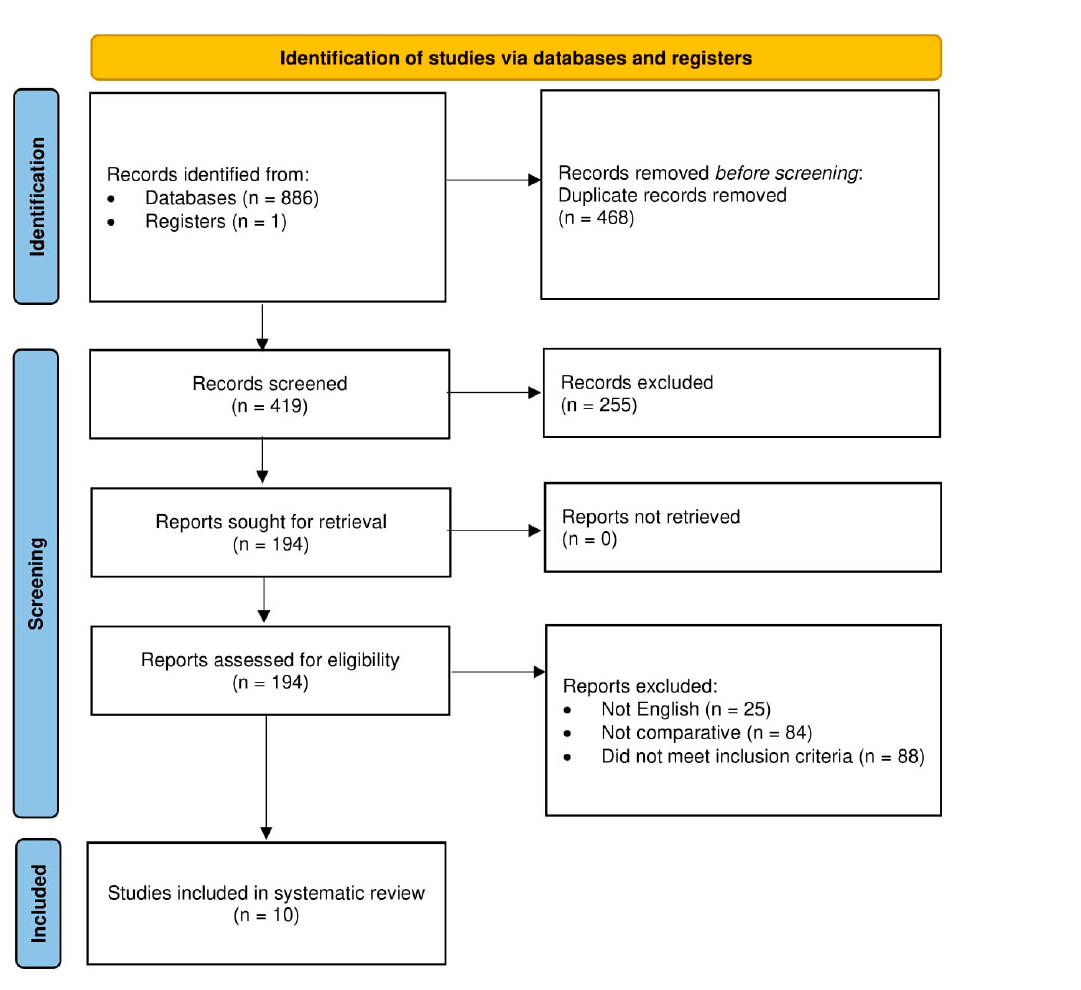
Figure 2. PRISMA 2020 flow schematic of the search approach used to discover pertinent comparative studies on minimally invasive segmentectomy versus lobectomy. Table 1. A summary of the studies that comprised the systematic review and meta ‐ analysis. RATS